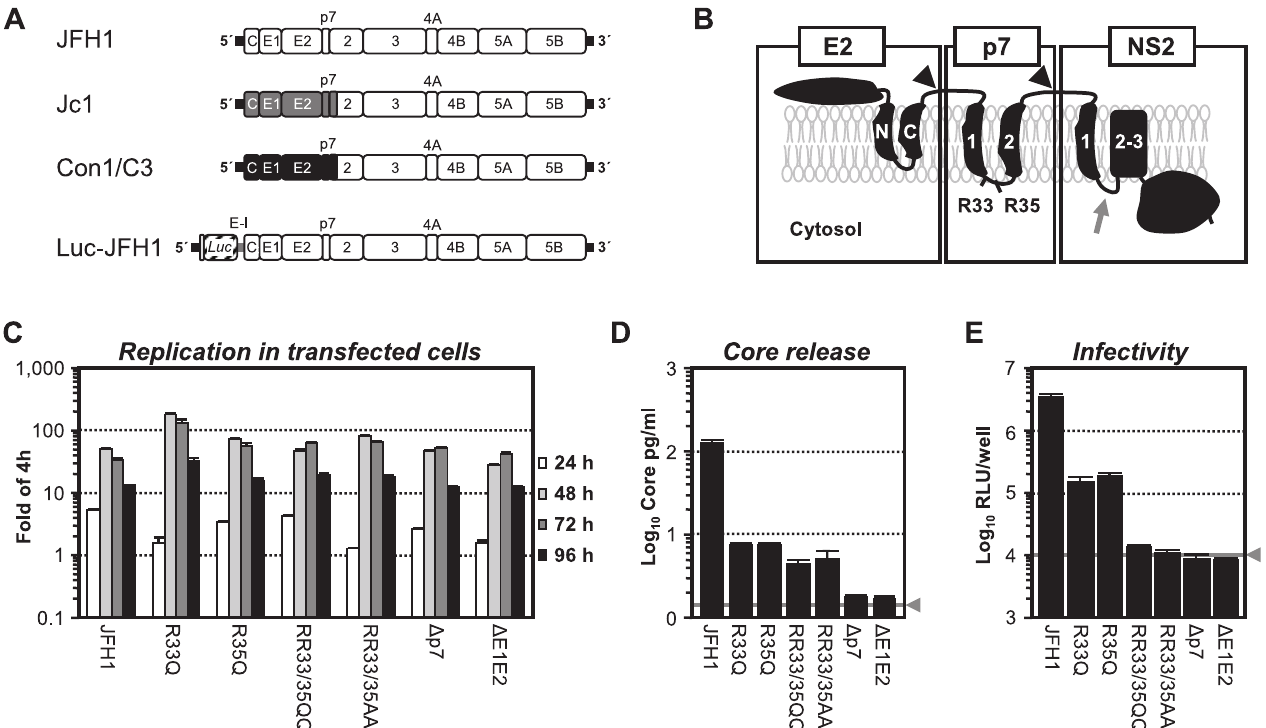
Figure 1. Replication and Virus Production of Luc-JFH1 Genomes with Mutated p7 (A) Schematic representation of constructs used in this study. JFH1-derived 5 9 and 3 9 nontranslated regions are drawn as thick black lines and JFH1 proteins are depicted as open boxes. Jc1 and Con1/C3 have been described and comprise chimeric HCV polyproteins consisting of J6CF (gray boxes) or Con1 (black boxes) fused with JFH1 [19]. The luciferase reporter virus genome Luc-JFH1 is depicted at the bottom [21]. (B) Topology model of E2, p7, and NS2 proteins. Signalase cleavage sites are denoted by black arrowheads. The location of conserved di-basic motif of p7 is indicated. C- and N-terminal portion of the E2 TM domain are labeled N and C, respectively, while predicted TM helices 1 and 2 of p7 are labeled 1 and 2. Predicted NS2 TM helix 1 is labeled 1 while the two following predicted helices are labeled 2/3. Note that the crossover site in the virus chimeras is located in the loop following TM helix 1 of NS2 (gray arrow) [19]. (C) Replication of Luc-JFH1 and given mutants in transfected Huh7-Lunet cells determined by luciferase reporter assays. Values given are expressed relative to the reporter activity measured at 4 h which was set to one. Mean values of duplicate measurements and the standard errors are given. (D) Release of core protein into the culture fluid 72 h post-transfection of cell given in (C). The gray lines indicate the cut-off of the ELISA and the background luciferase activity measured in mock-infected cells, respectively; mean values of duplicate measurements and the standard errors are given. (E) Infectivity associated with culture fluids harvested 72 h post-transfection determined by inoculation of Huh-7.5 cells and reporter assays. Mean values of duplicate wells and the standard error of the means are given. The gray line denotes background relative light units measured in mock- infected cells. Data presented in (C–E) were derived from a single experiment representative of five independent